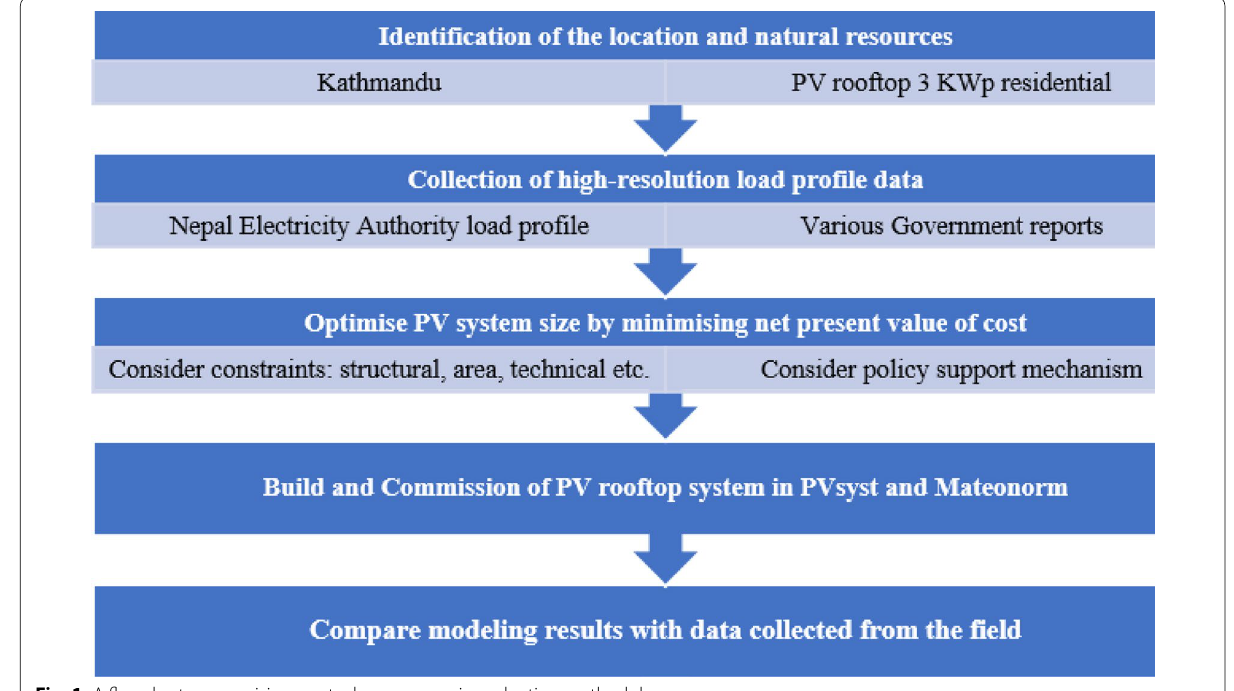
Fig. 1 A flowchart summarising our techno-economic evaluation